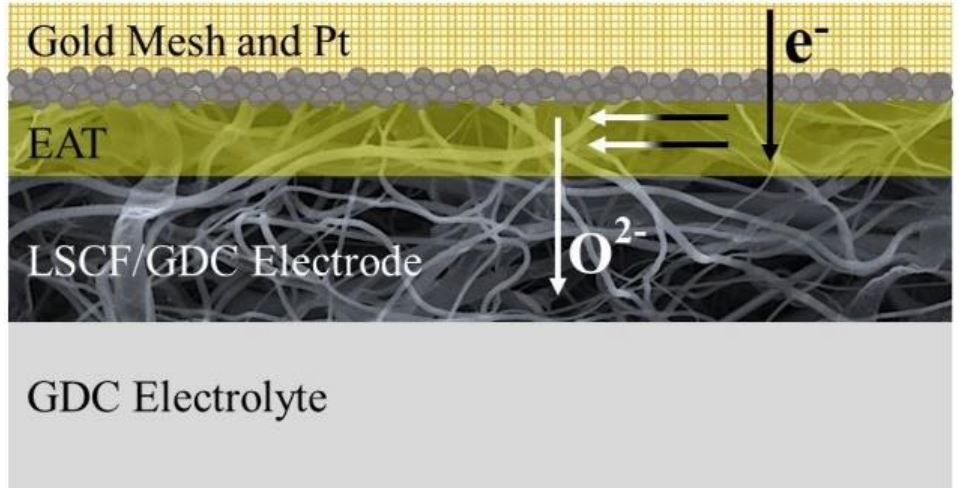
Figure 1. Scheme of a GDC/LSCF co-electrospun electrode. The EAT is the electrochemical active thickness, namely the layer of the electrode where the charge transfer reaction occurs. Reprinted with permission from ref [18]. Copyright 2021 Elsevier License Terms And Conditions.